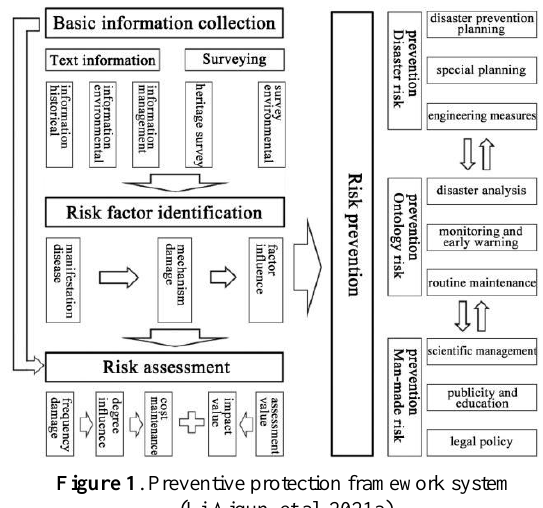
Figure 1 . Preventive protection framework system (Li Aiqun, et al.